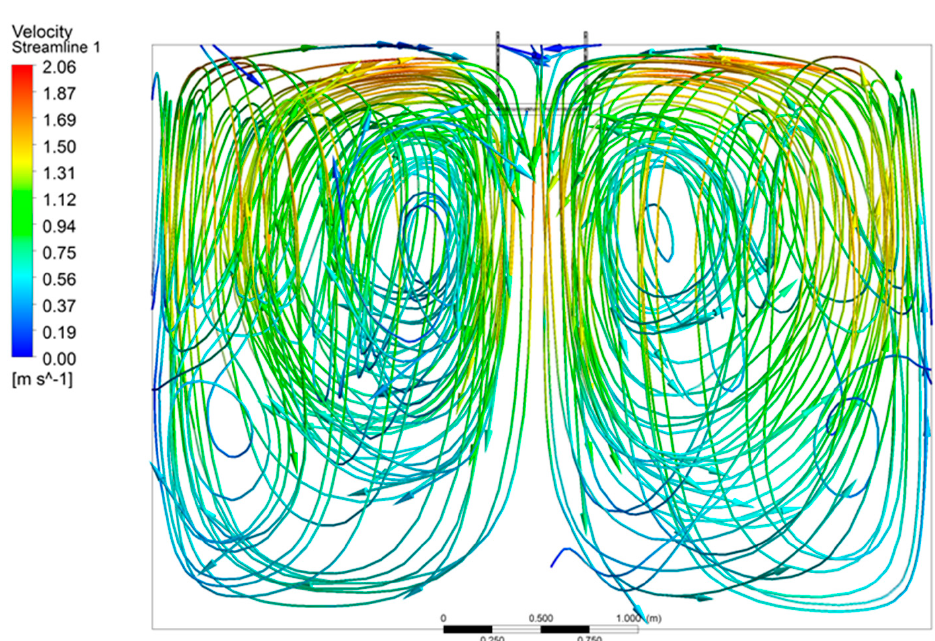
Figure 20. Model of passive cooling beam—the contours of velocity (m/s).